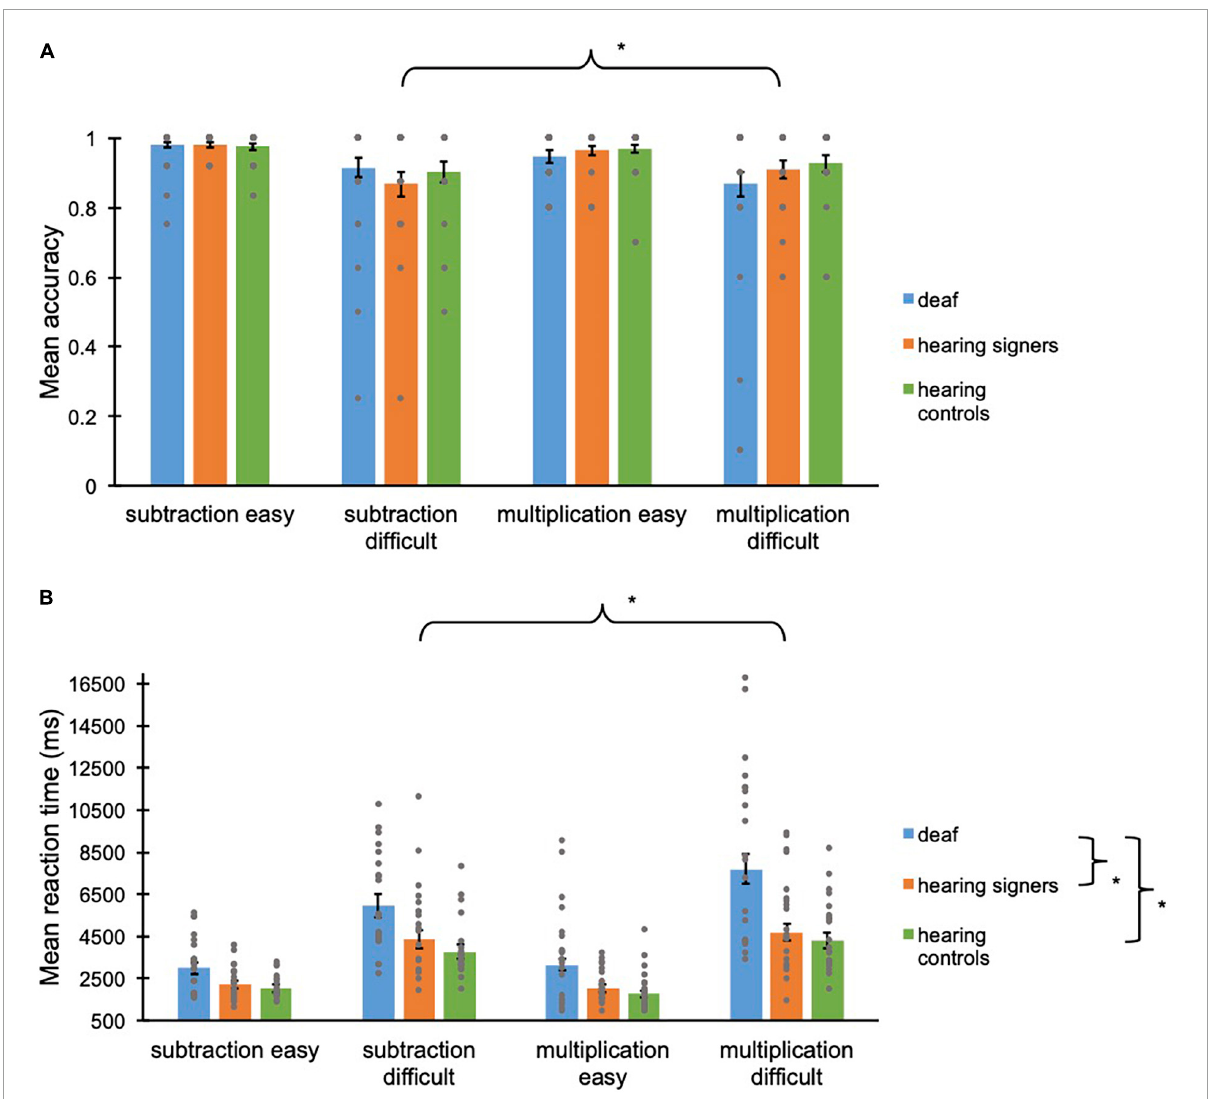
FIGURE1 (A) Mean accuracy scores (proportions) and (B) mean reaction times (ms) for deaf (in blue), hearing signers (in orange), and hearing controls (in green) for the two different operations, and the two different levels of the arithmetic task. Error bars represent the standard error of the means. Asterisks represent significant difference. Grey points represent individual mean